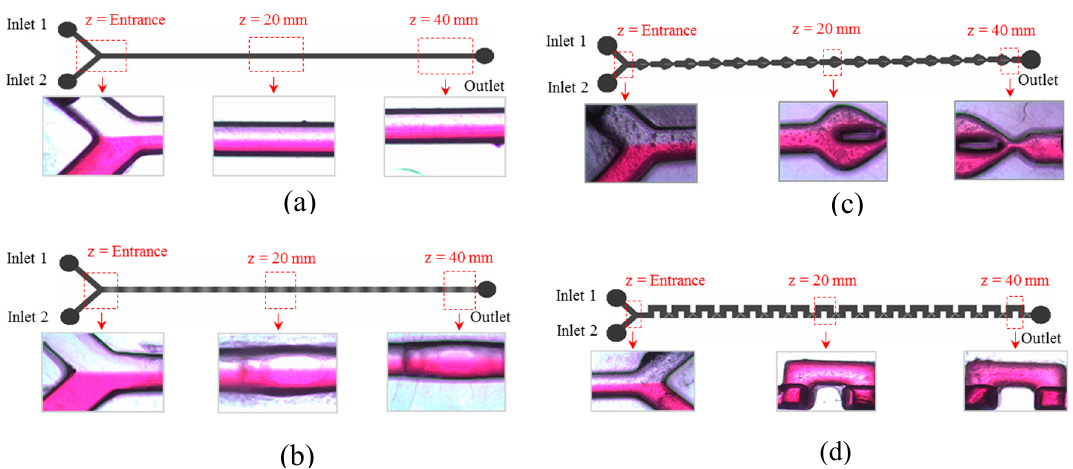
Figure 11. Experimental mixing results at the Y-junction, middle and end of mixing channel in: ( a ) Planar ( b ) Multi-step, ( c ) B-Spline and ( d ) 3D Serpentine micromixers.